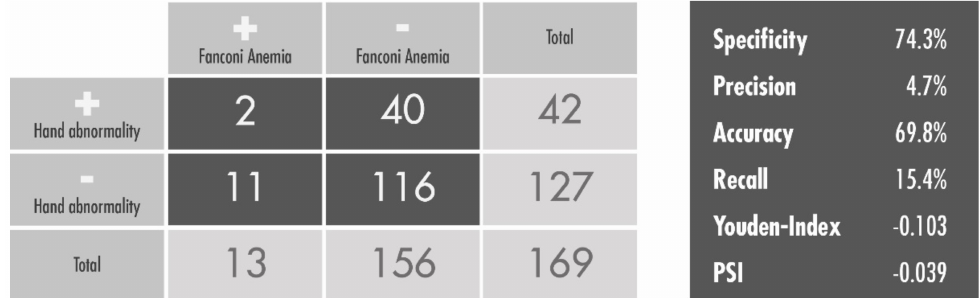
Figure 2. Correlations of hand abnormalities and Fanconi anemia. Chi-square test used to find correlations between isolated hand abnormalities (negative over positive) and Fanconi anemia (negative over positive) in our cohort. The two-tailed p value equals 0.522. Specificity, precision, accuracy, recall, Youden Index, and Predictive Summary Index (PSI) scores as test evaluation criteria are shown on the right.